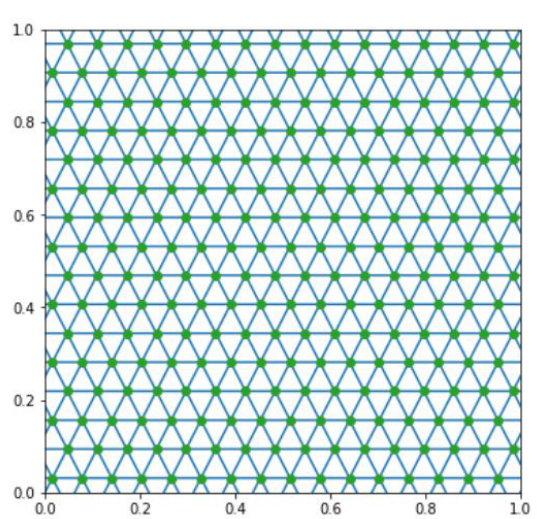
Figure 8. Samples of Z 2 class.